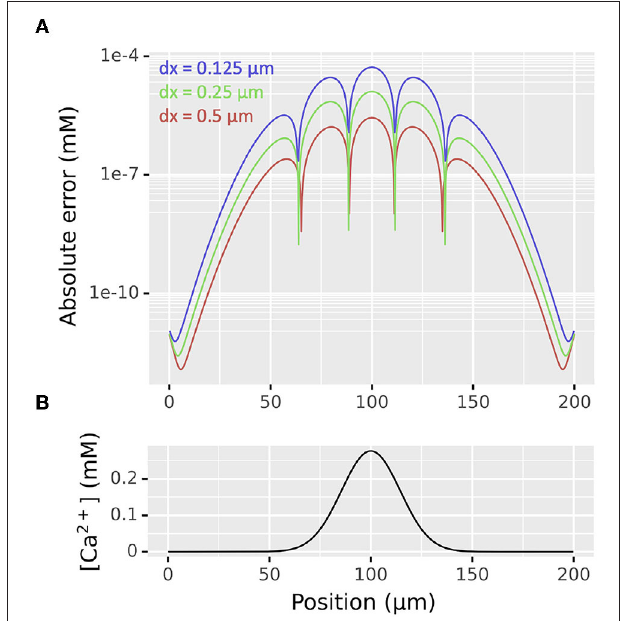
FIGURE 4 | (A) Distribution of absolute errors as functions of spatial discretization dx at t 100 ms from simulation of a diffusion problem on a = cylinder of length 200 µ m, diameter 1 µ m from an initial concentration of 1 mM between positions 95 and 105 µ m, 0 elsewhere. The apparent bumpy shape is an artifact of plotting the absolute value on a log scale; at each sudden drop in error the 3D simulated values switch from being an over- to an under-estimate or vice-versa. (B) Distribution of concentration at the same time point as determined by the analytic solution.